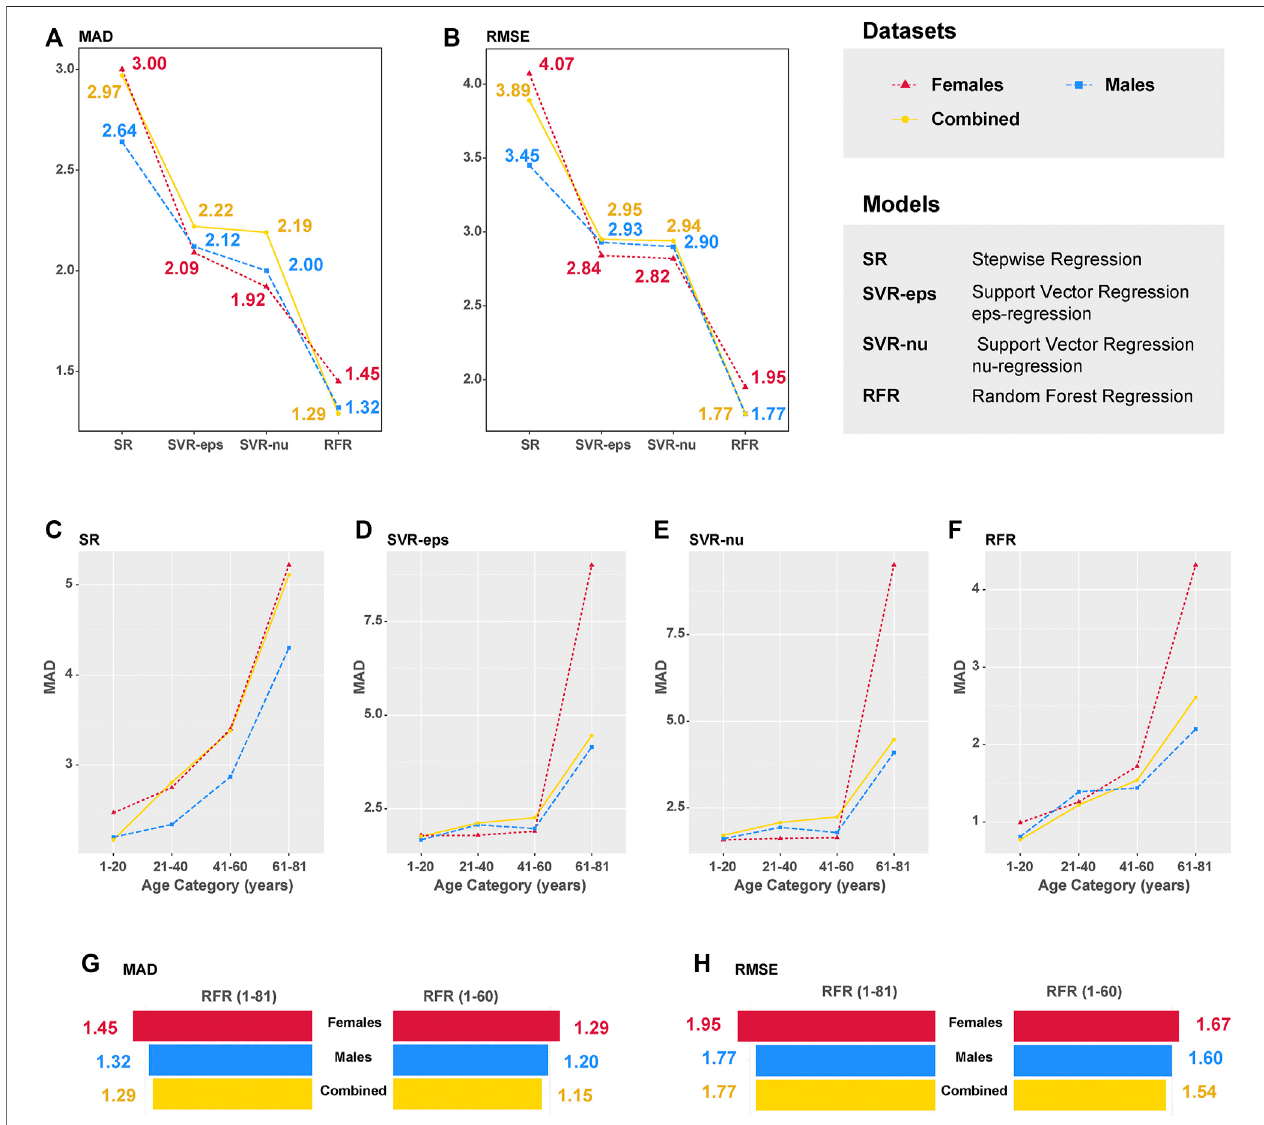
FIGURE 4 | Median absolute deviation ( MAD ) and root mean square error ( RMSE ) values of different machine learning (ML) models. (A) MAD value comparison of four different models in the CHS cohort ( n (cid:1) 240, blood samples). (B) RMSE value comparison of four different models in the CHS cohort ( n (cid:1) 240, blood samples). (C) MAD values in different age categories of the SR model. (D) MAD values in different age categories of the SVR-eps model. (E) MAD values in different age categories of the SVR-nu model. (F) MAD values in different age categories of the RFR model. (G) MAD value comparison between RFR (1 – 81) and RFR (1 – 60) models. (H) RMSE value comparison between RFR (1 – 81) and RFR (1 – 60)